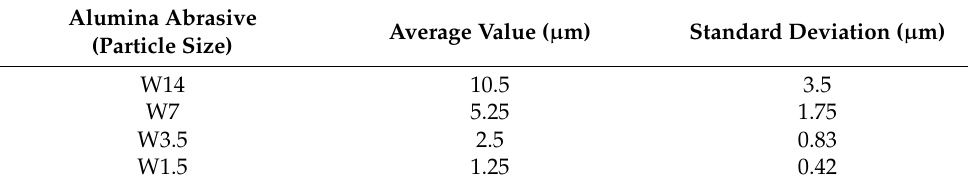
Table 1. Normal distribution parameters of Al 2 O 3 abrasive